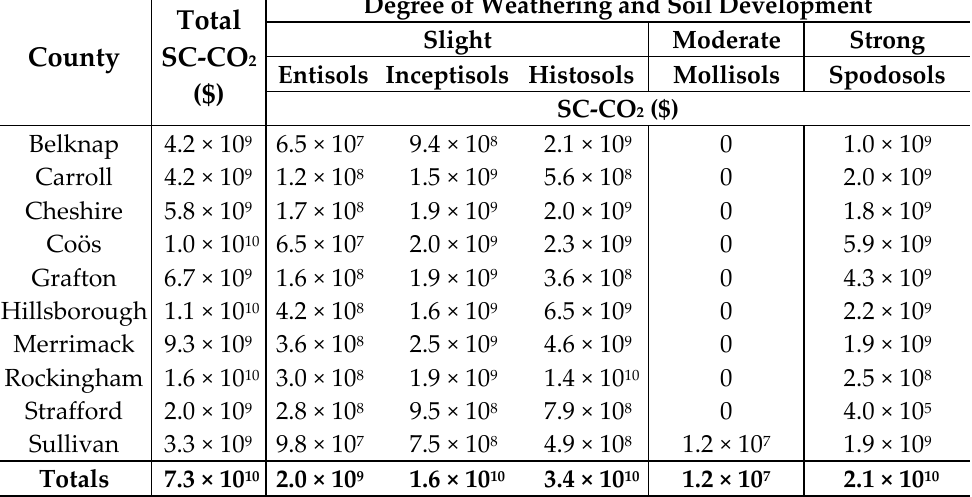
Table 10. Monetary value of total soil carbon (TSC) by soil order and county for the state of New Hampshire (USA), based on the areas shown in Table 3 and the area-normalized midpoint monetary values shown in Table 4.